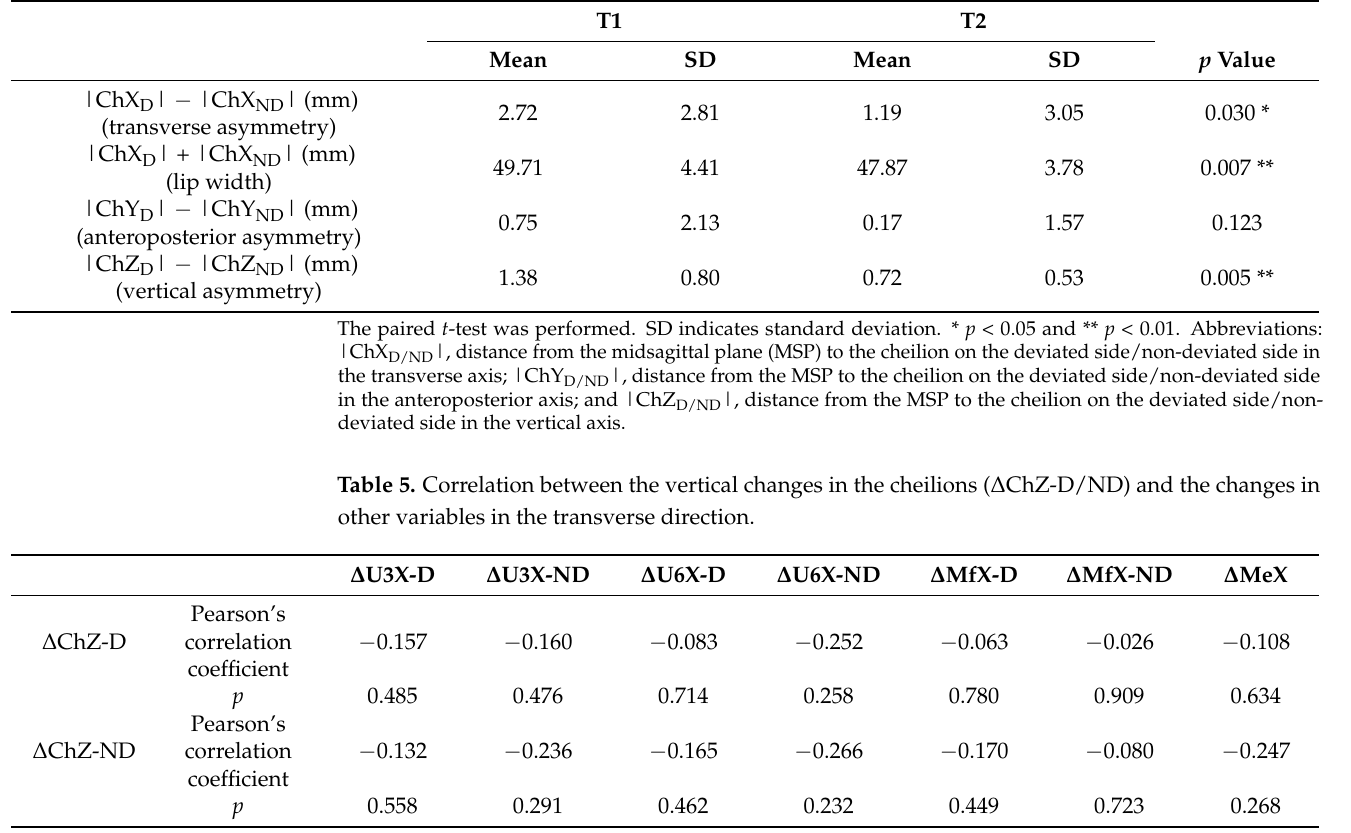
Table 4. Changes in distance from the deviated side cheilion to the non-deviated side cheilion after surgery. T1 T2 Mean SD Mean SD p Value